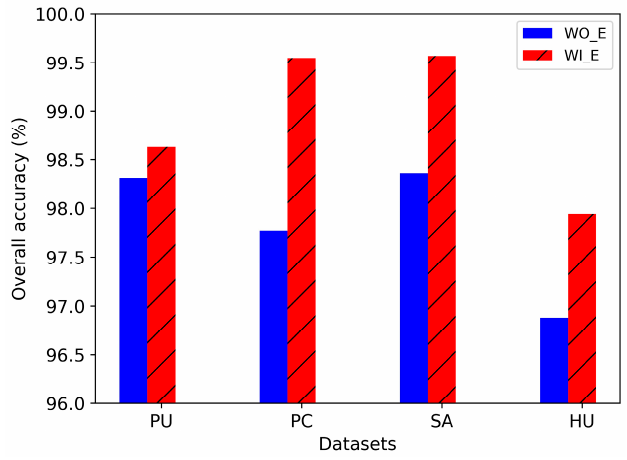
Figure 15. Effectiveness of feature enhancement module.